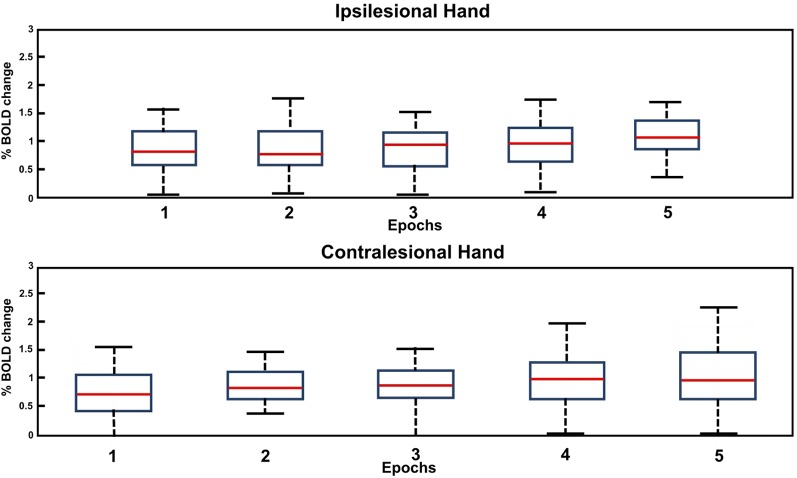
Box plot of the BOLD amplitude variation through the five epochs of the motor task for the affected (contralesional) and unaffected (ipsilesional) hand in the case of NCP for the M ROI.